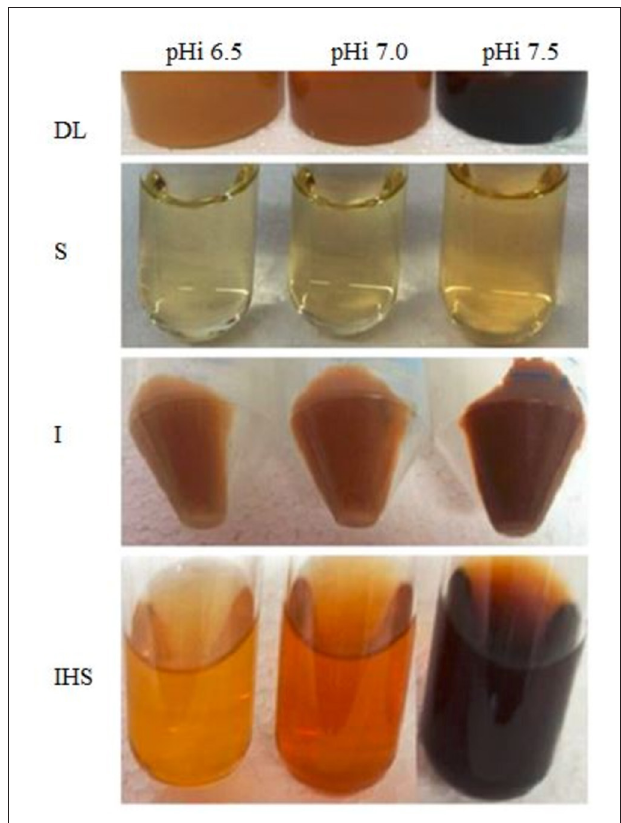
FIGURE 3 | Color of DL prepared at different pH i values and the respective fractions obtained from each product.